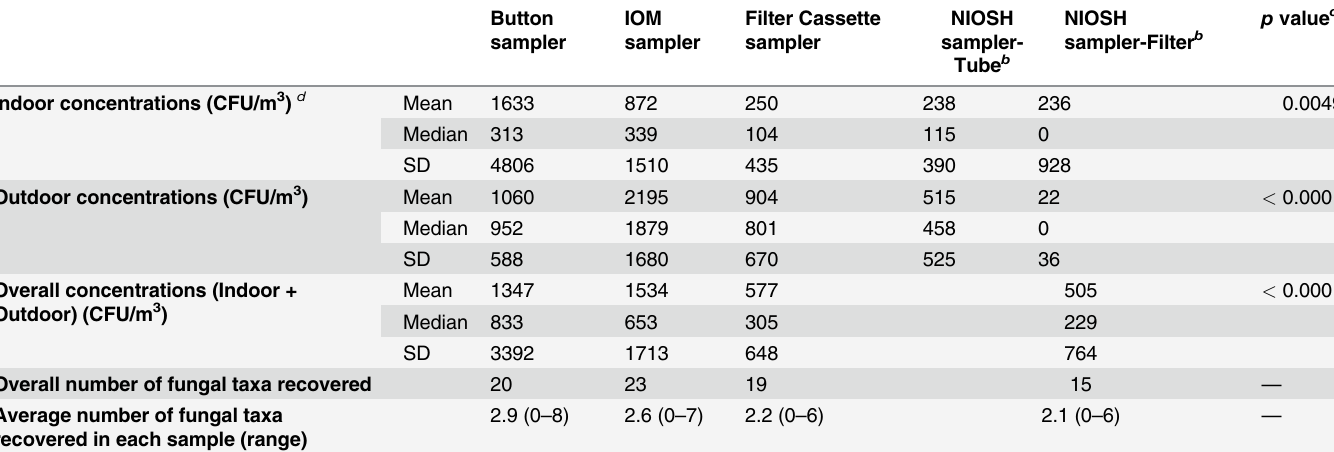
Table 4. Relative efficiency comparison of personal samplers based on total culturable fungal concentrations and diversity. a